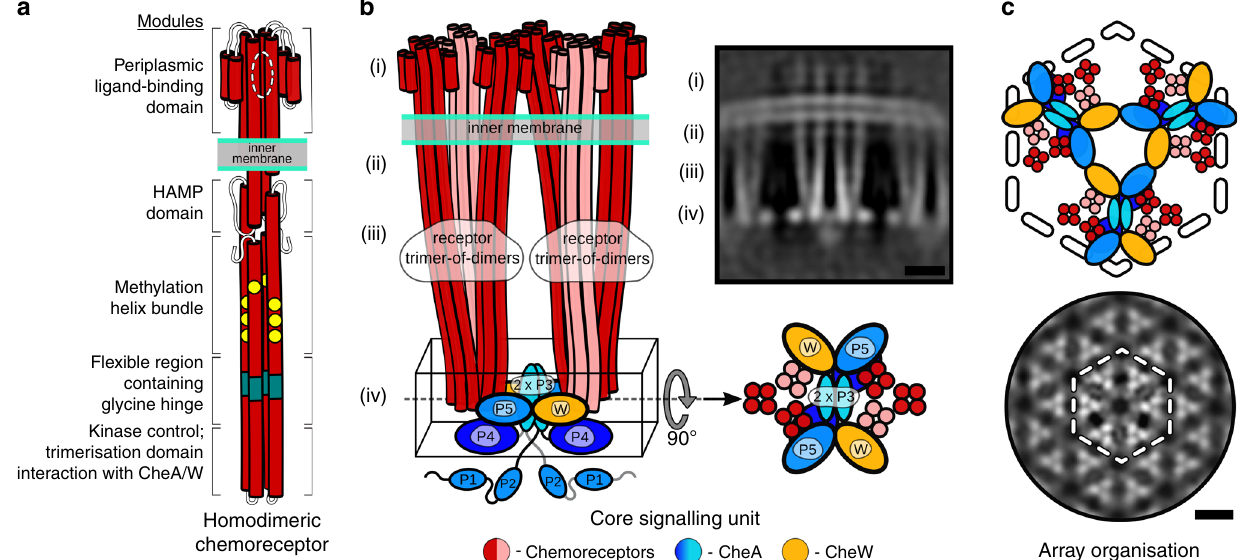
Fig. 1 Overview of chemoreceptor, CSU and chemoreceptor array architectures. a Schematic representation of homodimeric chemoreceptor structure. Red cylinders represent α -helical secondary structures drawn approximately to scale, fl exible hinges are drawn as thin wavy strings, important regions discussed further in the text are highlighted (methylation sites as yellow circles, glycine hinges as teal cylinders). Regions encompassed in square brackets are the periplasmic ligand-binding domain (PP), the HAMP domain (HAMP), the methylation-helix bundles (MH), a fl exible region containing the glycine hinge (GH) and the trimerisation and kinase control domain (KC) which is the site of interaction with CheA and CheW. b — left Two receptor ToDs interact with CheA and CheW to form a CSU shown from the side. Two MCP dimers in the CSU are shown in salmon for perspective. CheA is shown in shades of blue, and CheW in gold. CheA.P3, CheA.P4 and CheA.P5 are labelled and have known positions. Positions of CheA.P1 and CheA.P2 are not certain. The baseplate region is boxed. b — top right Same as in b — left shown as a 5 nm-thick projection through the density of our reconstruction. Roman numerals in b — left and b — top right refer to important regions of the structure — (i) the periplasmic domain, (ii) the HAMP domain, (iii) the methylation-helix bundle and (iv) the baseplate region. c — top CheA and CheW from three neighbouring CSUs interact to form chemoreceptor arrays, shown schematically and c — bottom as a 5 nm projection through the density of our reconstruction. The same region in c — top and c — bottom is delimited by a dashed hexagon. In b — top right and c — bottom, protein density is shown in white and scale bars are 10 nm. Source data are provided as a Source Data fi